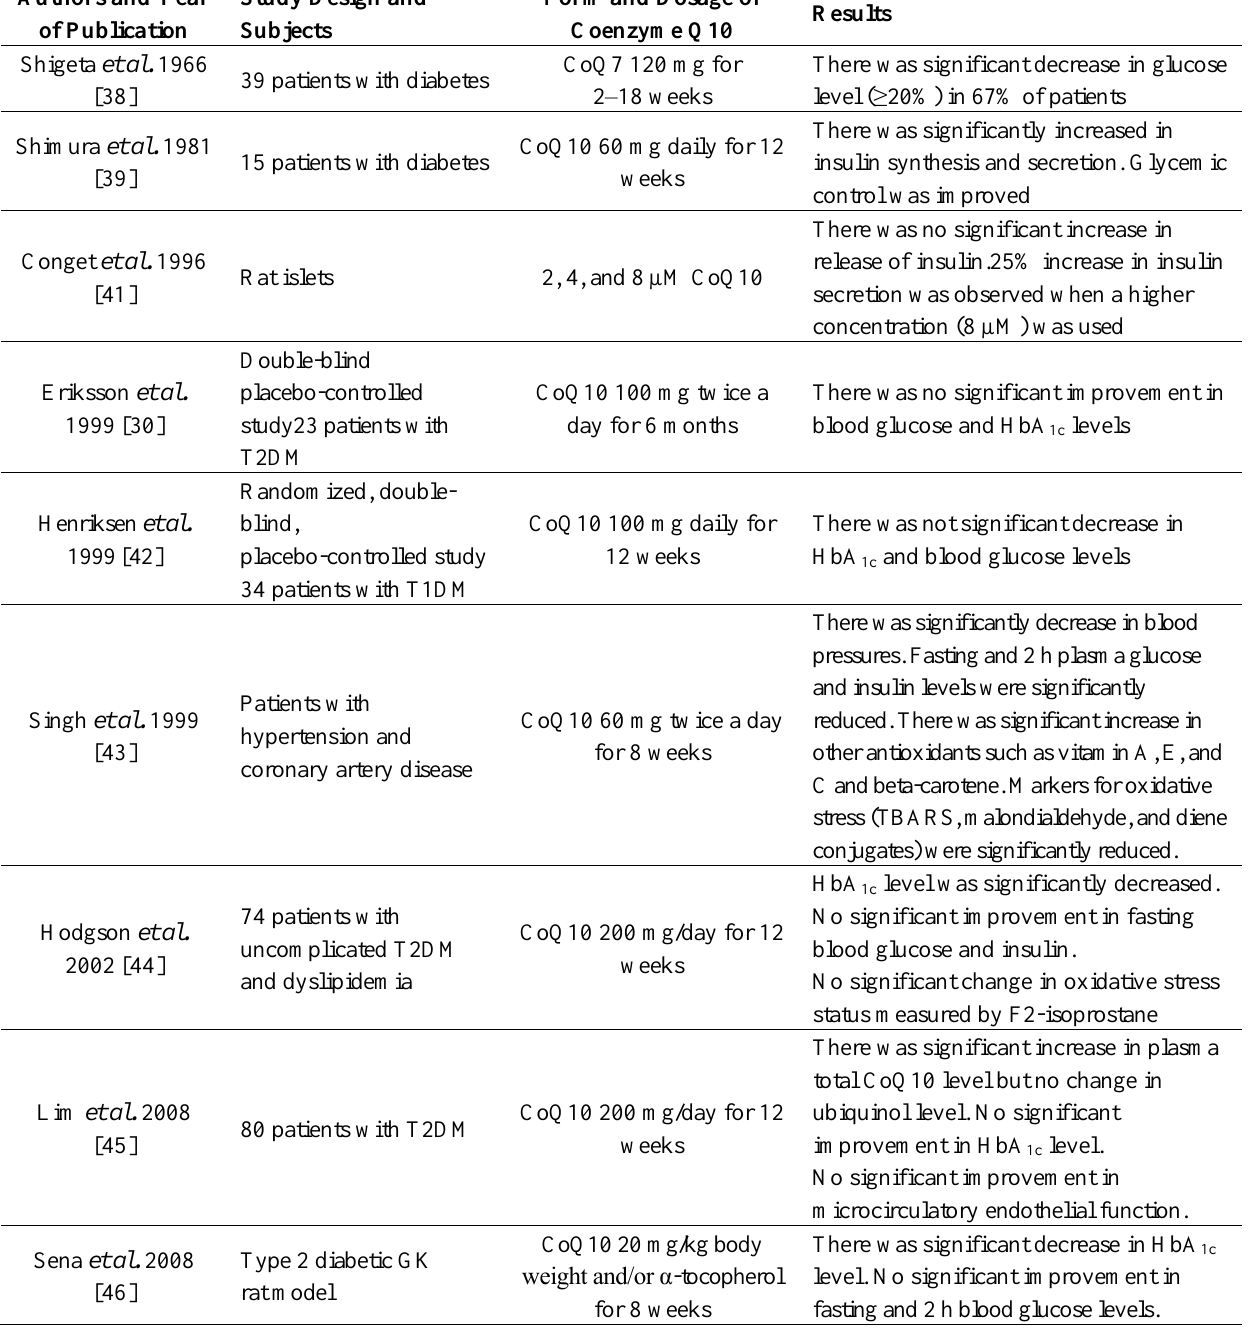
Table 1. Effects of Coenzyme Q10 Supplementation on Glycemic Control among Patients with Type 2